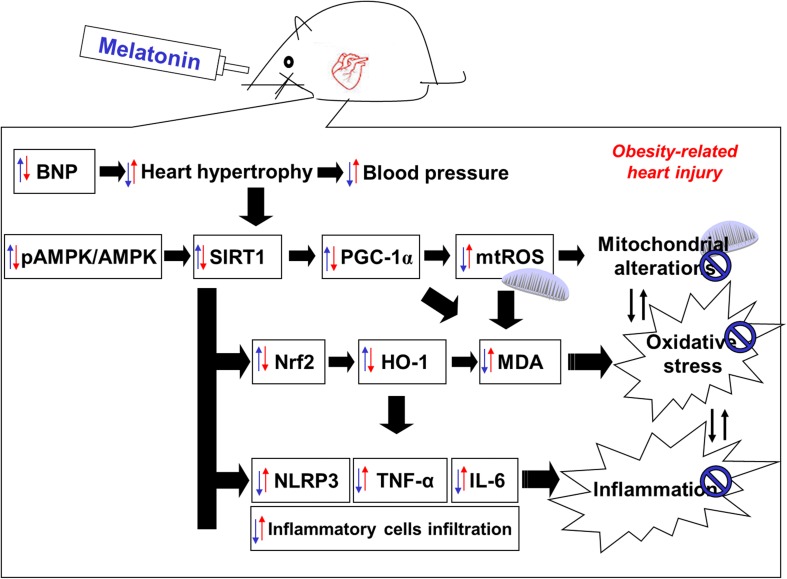
A schematic representation of sirtuin1 involvement in the proposal melatonin mechanisms of action (blue arrows) against obesity-related cardiac injury (red arrows). AMPK, AMP-activated protein kinase; BNP, natriuretic peptides type-B; HO-1, heme oxygenase-1; mtROS, mitochondrial reactive oxygen species; NLRP3, nucleotide oligomerization domain like receptor 3; Nrf2, nuclear factor erythroid-derived 2-like 2; pAMPK, phosphoAMP-activated protein kinase; PGC-1α, peroxisome proliferator activated receptor gamma coactivator-1alpha; SIRT1, sirtuin1; TNF-α, tumor necrosis factor-alpha.